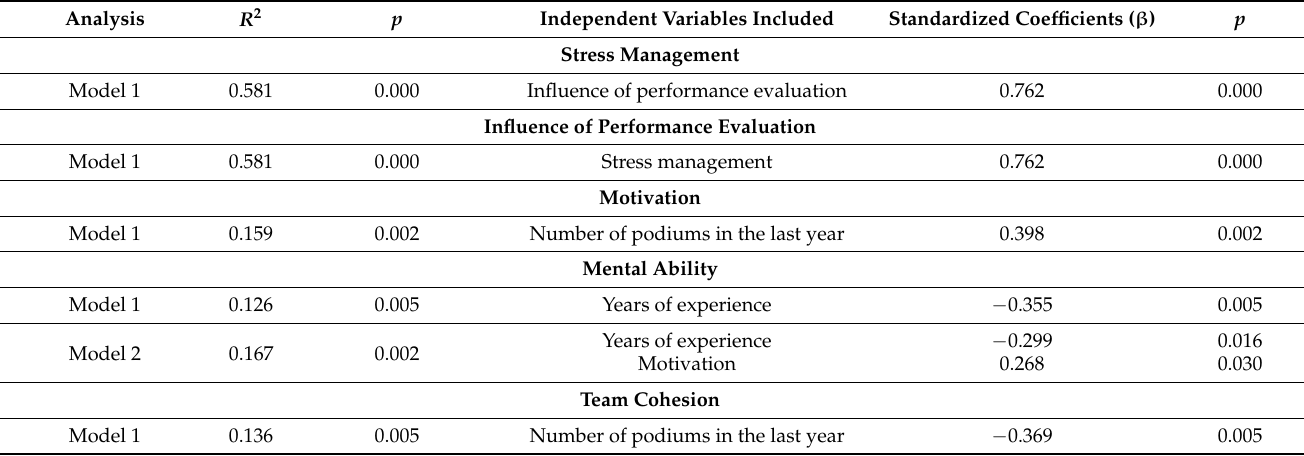
Table 4. Linear regression analysis for the psychological profile of female cyclists based on psychological, training, performance, and injury history parameters in female